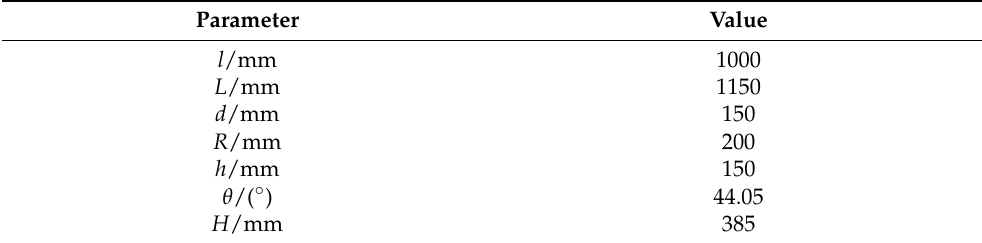
Table 4. Structural parameters of the